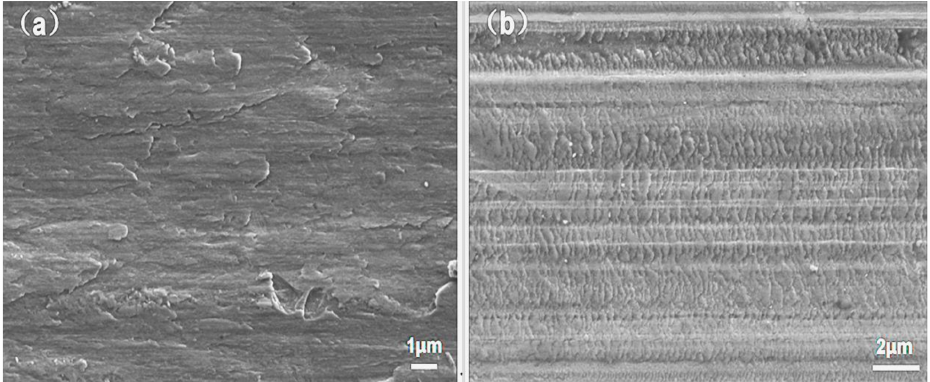
Figure 8. SEM images of the worn surfaces of HEA coatings after 800 ◦ C/60 min friction and wear tests: ( a ) AlCoCrFeNi coating; ( b ) AlCoCrFeNiW 0.5